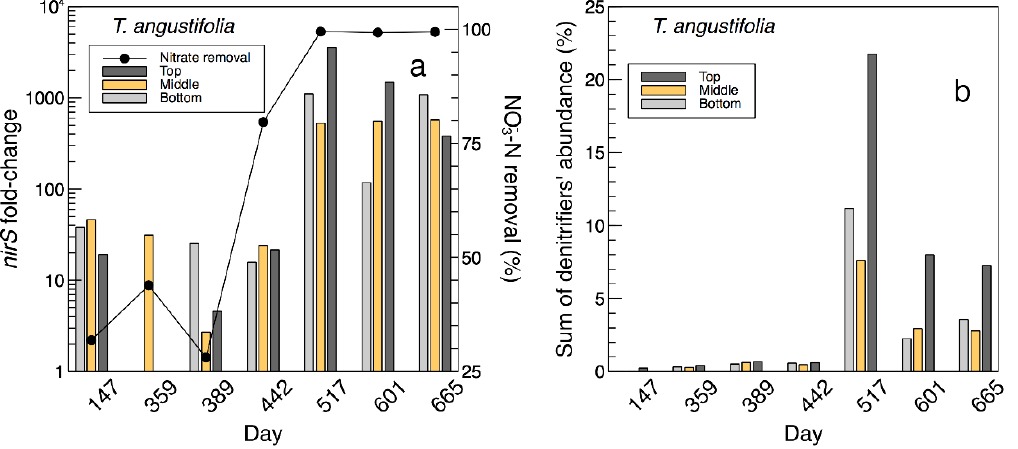
Figure 8. a : Temporal nirS fold-change in T. angustifolia bioreactor at 3 depths and reactor’s nitrate removal rate (derived from [2]). b : Temporal change of the sum of abundance of common denitrifiers in the T. angustifolia reactor.